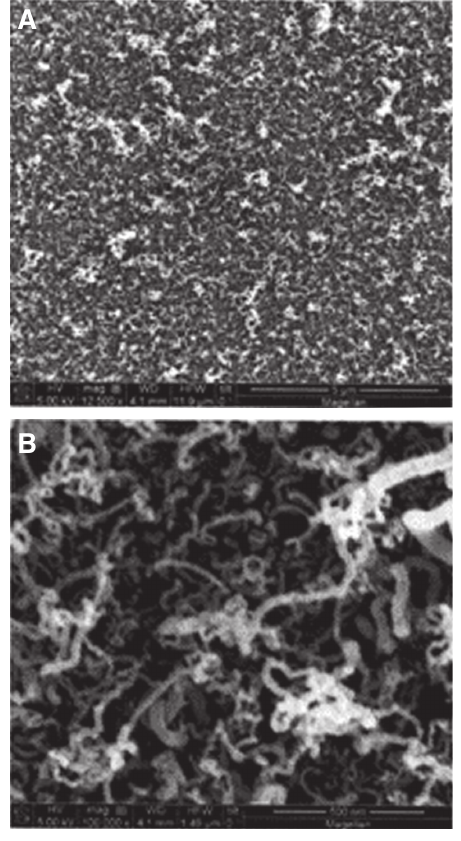
Figure 2 (A) Example of SEM image of the CNTs at low magnifica- tion. (B) Example of SEM image of the CNTs at high magnification (case 3 wt%).